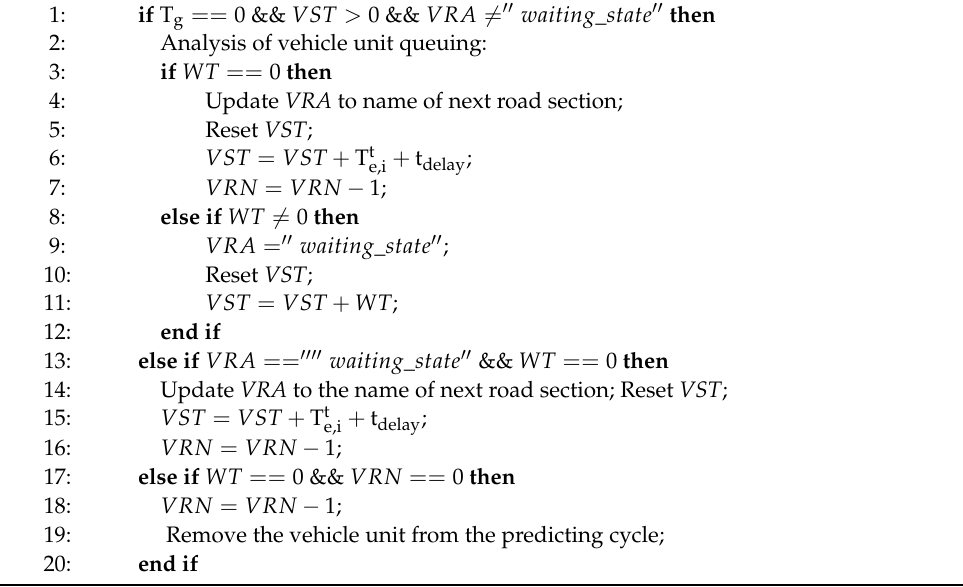
Algorithm 1 The update strategy of the state of vehicle unit